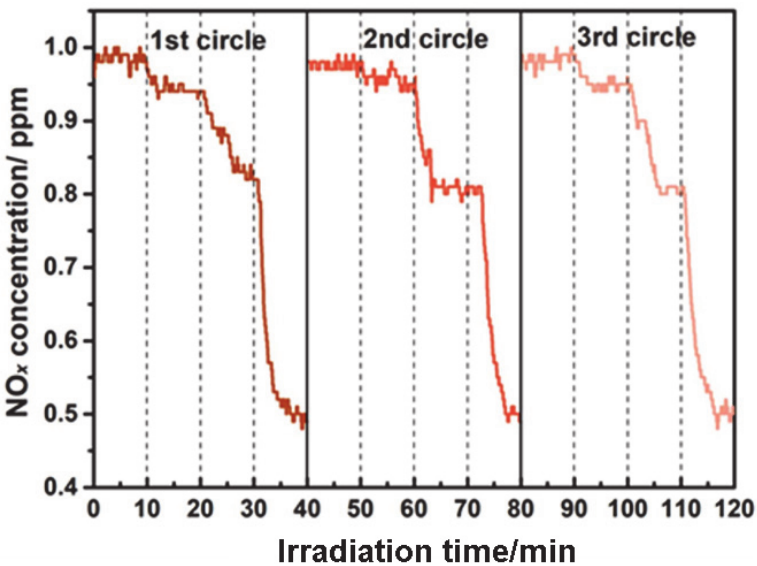
Figure 2. Recycling tests of photocatalytic NO degradation by N ‐ LTO_NC (650). (Reprinted with